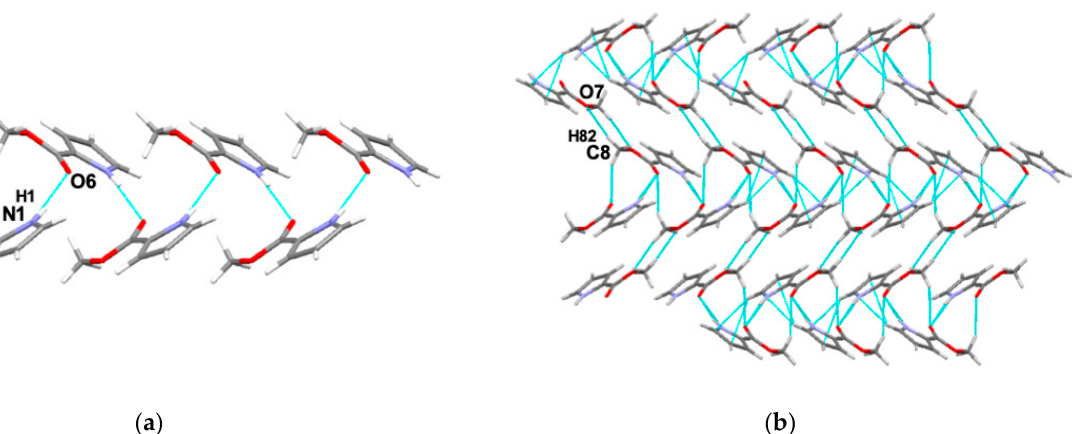
Figure 6. Molecular arrangement in structure III . ( a ) An a -axis viewed chain of N-H · · · O. H-bond parameters [N1-H1 · · · O6] N1-H1 0.88(2)Å, H1 · · · O6(1-x,1/2+y,1/2-z) 2.06(2)Å, <N1H1O6 171(1) ◦ . ( b ) View of the N-H · · · O chains connected by C-H · · · O hydrogen bonds and stabilized by C-H · · · π interactions. H-bond parameters [C8-H82 · · · O7] C8-H82 0.97(2)Å, H82 · · · O7(1-x, − 1-y,1-z) 2.63(2)Å, <C8H82O7 156(1) ◦ , [C5-H5 · · · Cg1] C5-H5 0.95(2)Å H5 · · · Cg1 (1-x,1/2+y,1/2-z) 2.64(2)Å, <C5H5Cg1 139(1) ◦ .